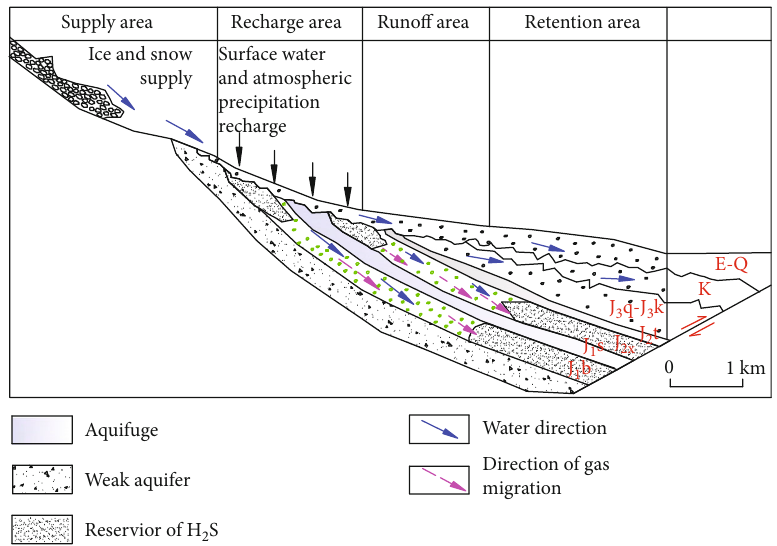
Figure 6: Single bevel of H S formation and accumulation model in the east of Urumqi. 2